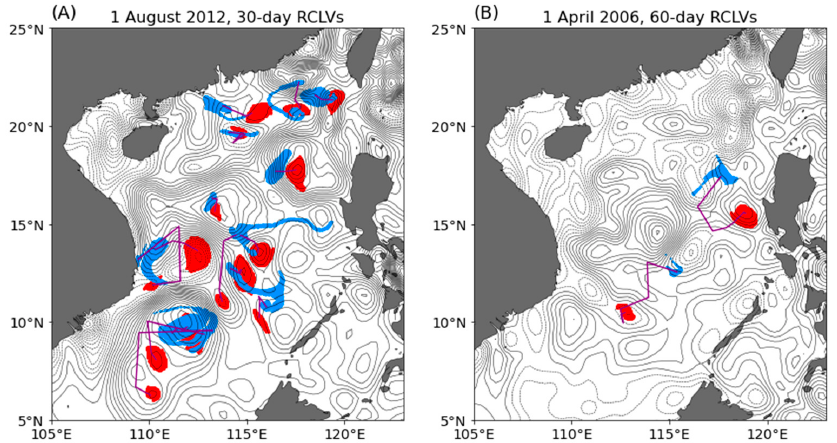
Figure 10. Initial (red dots) and final (blue dots) locations for ( A ) 30-day and ( B ) 60-day RCLVs in two random time intervals. The purple line indicates the eddy trajectory. The black contours represent the SLA on the initial date with an interval of 2 cm.